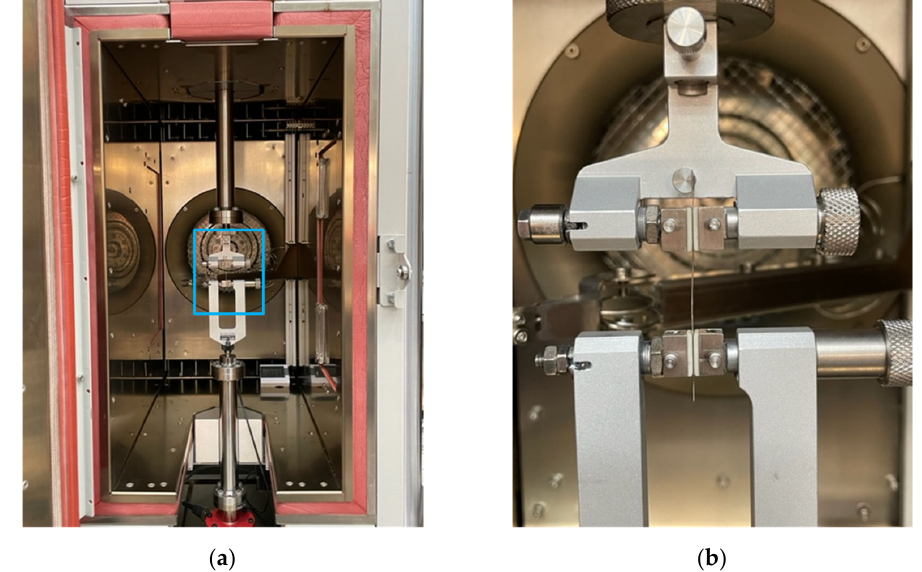
Figure 1. Measurement setup with a fixed wire in the clamping jaws in the furnace of the LTM 1 HR from Zwick Roell ( a ); detailed picture of a fixed wire in the clamping jaws ( b ). The fatigue tests were carried out with a 100 N load cell and a clamping length of 20 mm at a frequency of 40 Hz with sinusoidal load. The applied stress amplitudes σ a were varied in 0.5 MPa steps for the individual R ‐ ratios. The R ‐ ratio was varied in the range between 0.1 and 0.7 with steps of 0.1 for Al ‐ Pure. Al ‐ Prime is tested with R ‐ ratios of 0.1, 0.4 and 0.7. The R ‐ ratio is defined by the quotient of minimum stress σ min and maximum